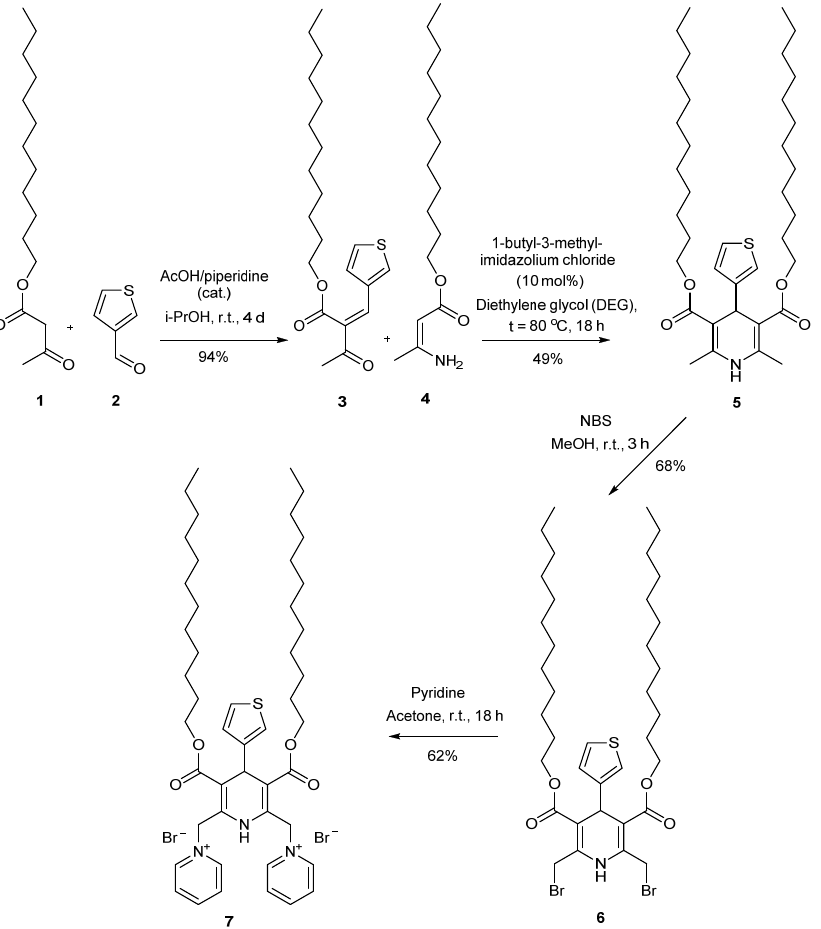
Scheme 1. Synthesis of 1,1 (cid:48) -{[3,5-bis(dodecyloxycarbonyl)-4-(thiophen-3-yl)-1,4-dihydropyridine-2,6- diyl]bis-(methylene)}bis(pyridin-1-ium) dibromide ( 7